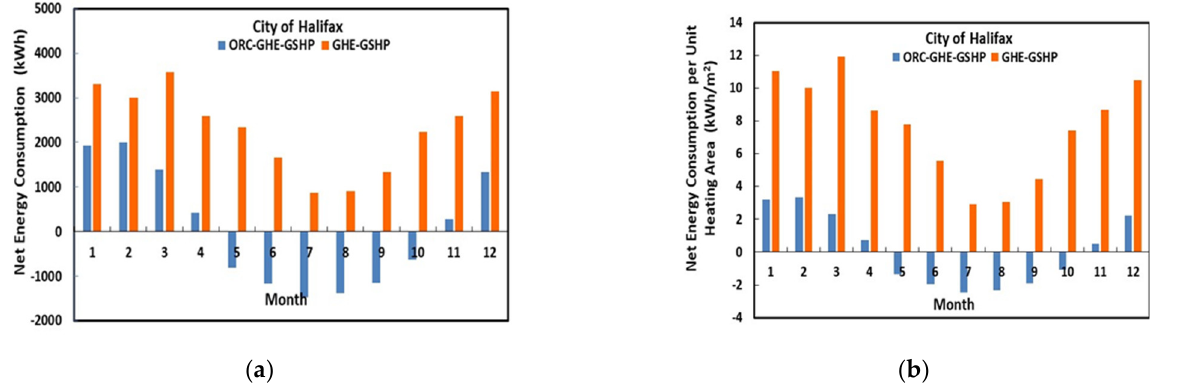
Figure 11. ( a ) Net energy consumption; ( b ) net energy consumption per unit heating area during the first year in Halifax for ORC-GHE-GSHP and conventional GSHP systems.